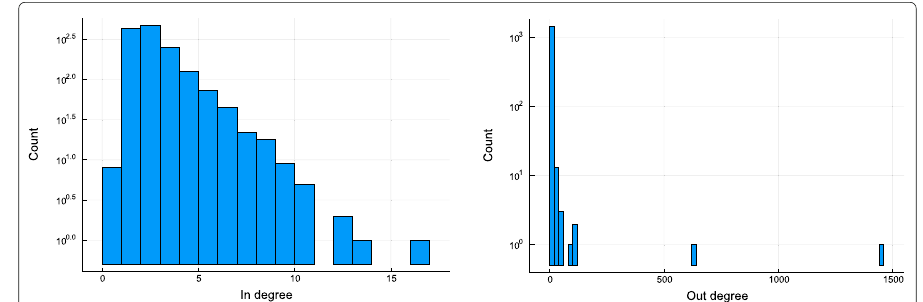
Fig. 2 Elm degree distributions. In and out degree distributions for the Elm package